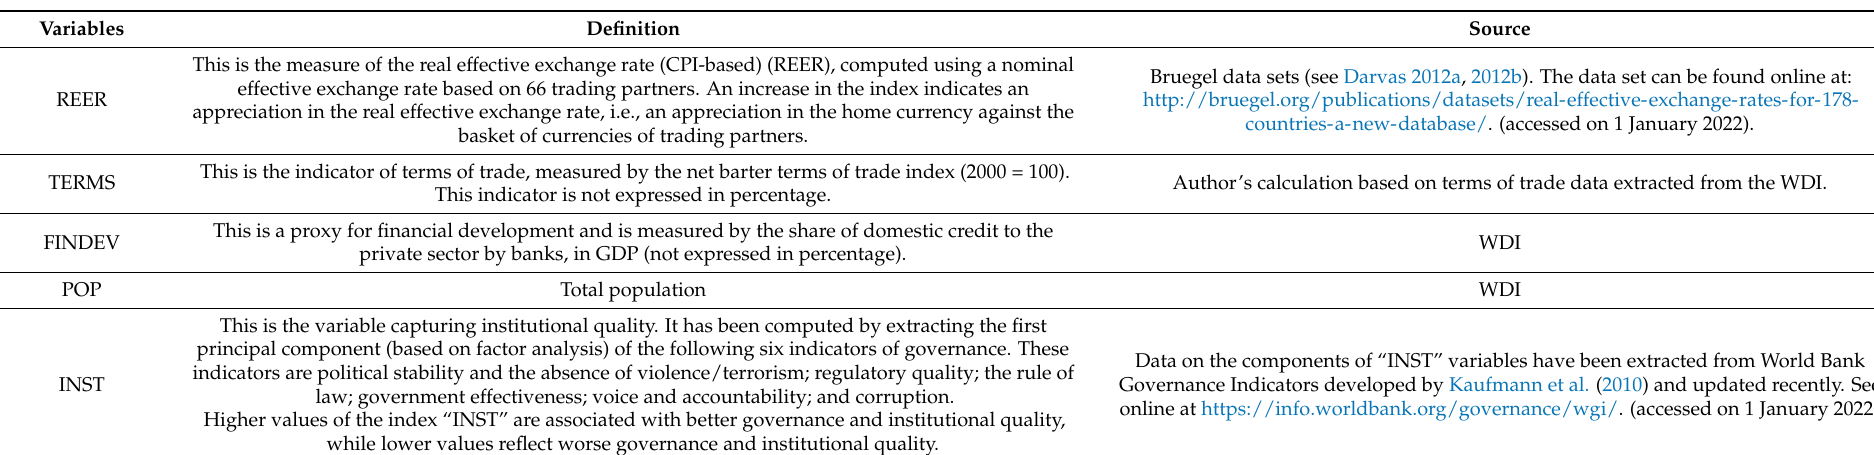
Table A1. Definition and source of